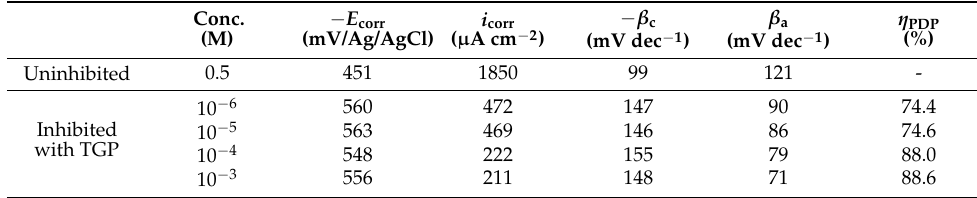
Figure 1. PDP plots for MS in an 0.5 M H 2 SO 4 environment, uninhibited and inhibited with inhibitory resin at different concentrations. Table 1. PDP parameters for MS in 0.5 M H 2 SO 4 , with and without inhibitory resin at di ff erent concentrations.